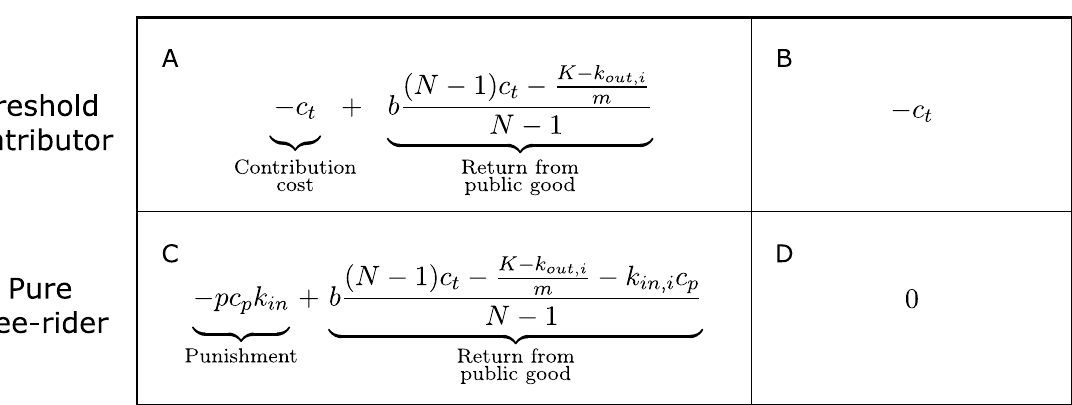
Table 2. Payoffs for threshold cooperation or pure free-riding for an individual under conditions where every other individual in the group is a threshold contributor or a pure free-rider. Threshold cooperation and pure free-riding are the only two Nash strategies and universal threshold contribution and universal free-riding are the only two possible socially efficient distributions of strategies within a